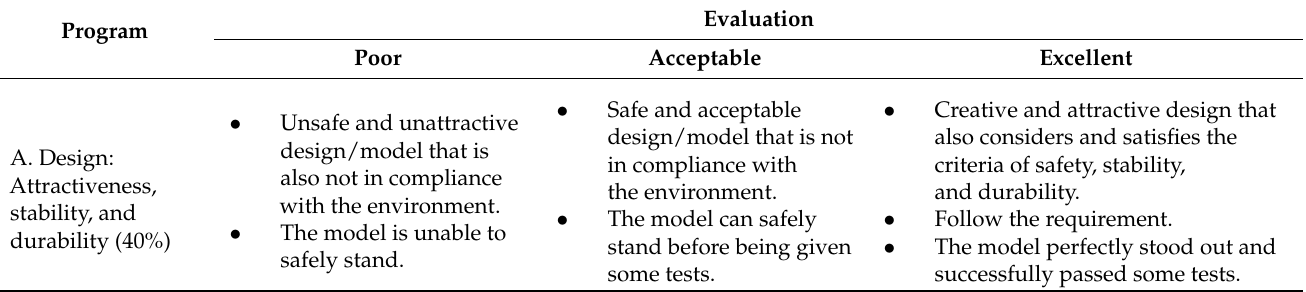
Table 6. Rubric of